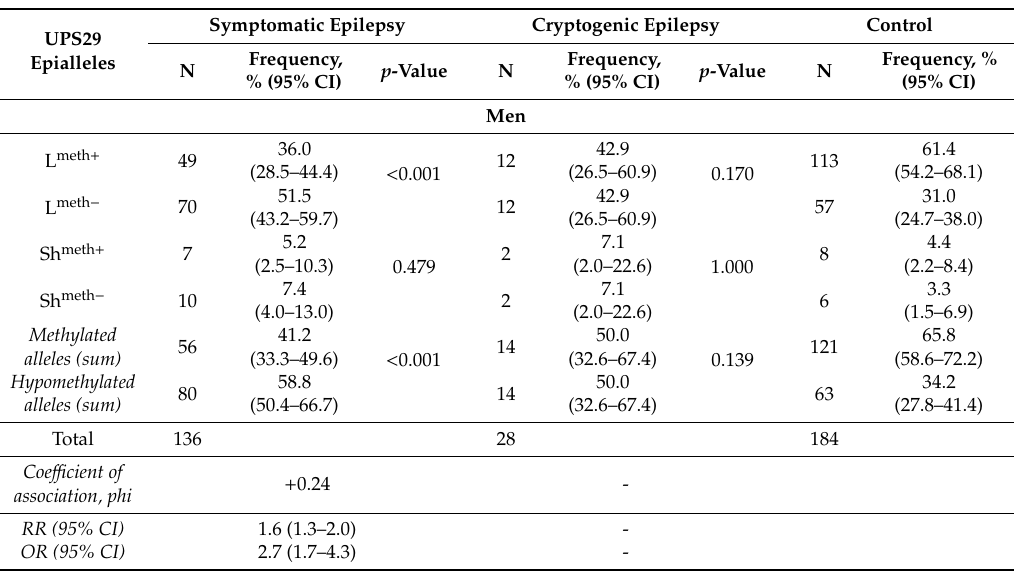
Table 8. The frequency of methylated and hypomethylated (unmethylated) UPS29 alleles in patients with epilepsy (symptomatic and cryptogenic) compared with the control